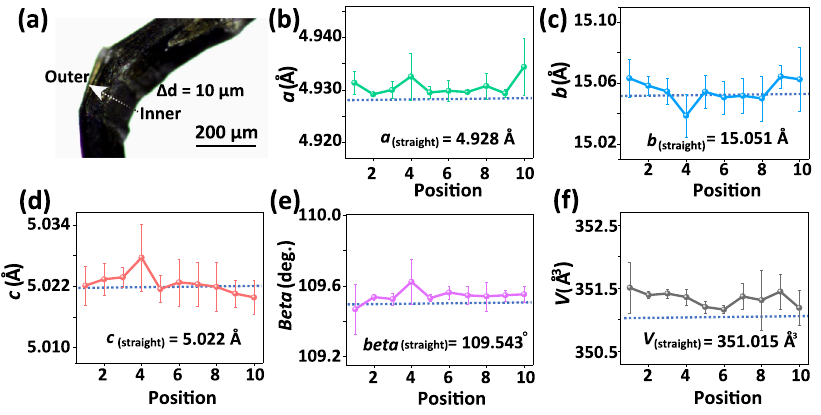
Fig. 2 | Synchrotron X-ray diffraction analysis of the bend of a Cu-Trz crystal. a Optical micrograph of a bent crystal. The insert scale bar represents 100 μ m. b – f Cellparameters( a , b , c , β , V )extracted from thediffractionpatternsata10 μ m